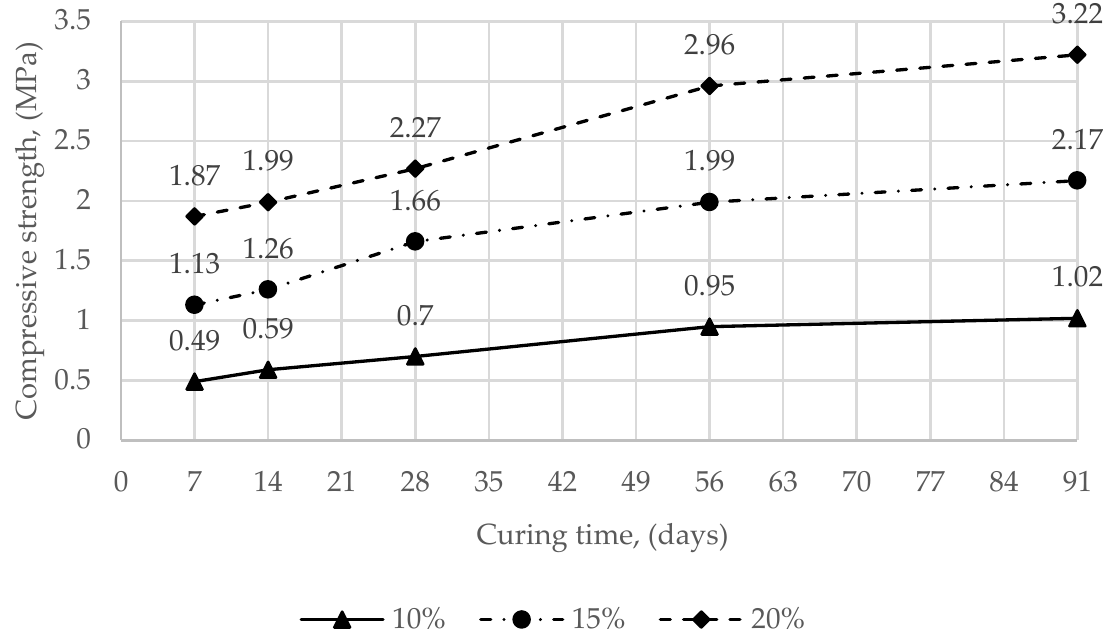
Figure 3. Compressive strength (samples of SCS with clay soil and 10%, 15%, 20% Carbofill E binder) development with time.